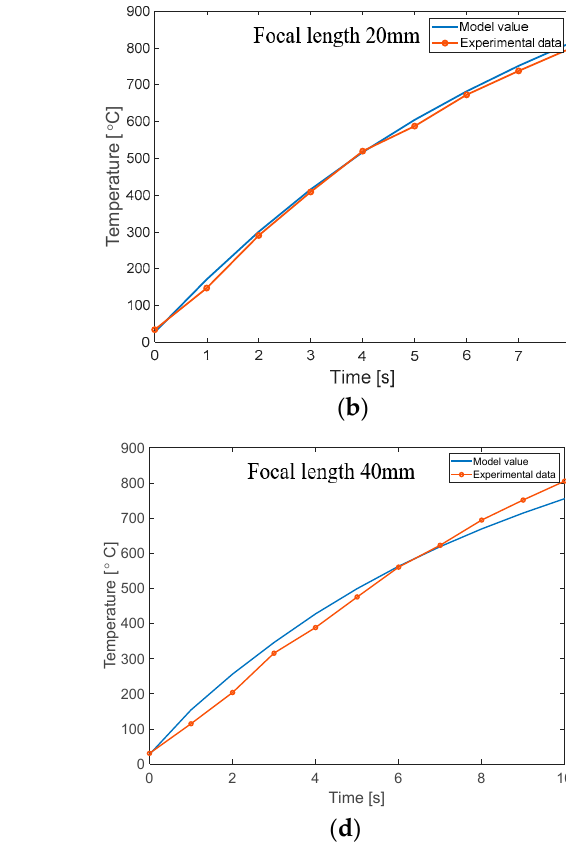
Figure 8. Comparison of the simulation and the experiment for the single-surface heating: ( a ) Tem- perature profile of the target material for the 20 mm focal length; ( b ) Heating rate at the center for the 20 mm focal length; ( c ) Temperature profile of the target material for the 40 mm focal length; ( d ) Heating rate at the center for the 40 mm focal length.